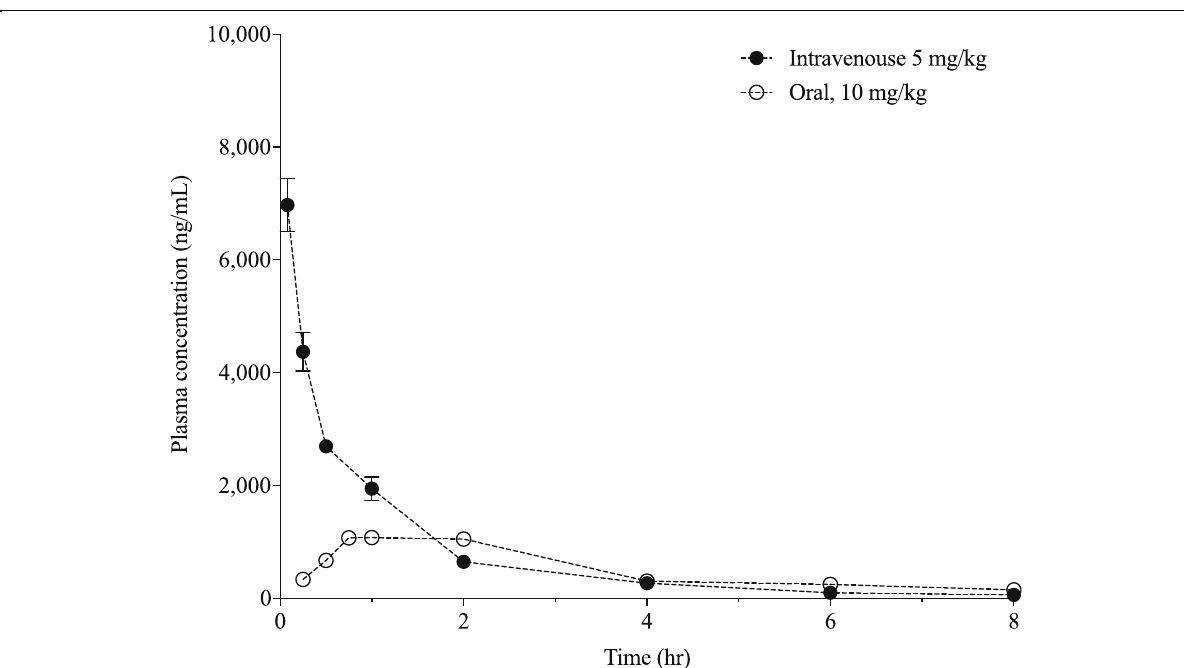
Fig. 3 Temporal profiles of larotrectinib concentrations in mouse plasma after an intravenous or oral administration of larotrectinib to mice (mean ± standard deviation, n =